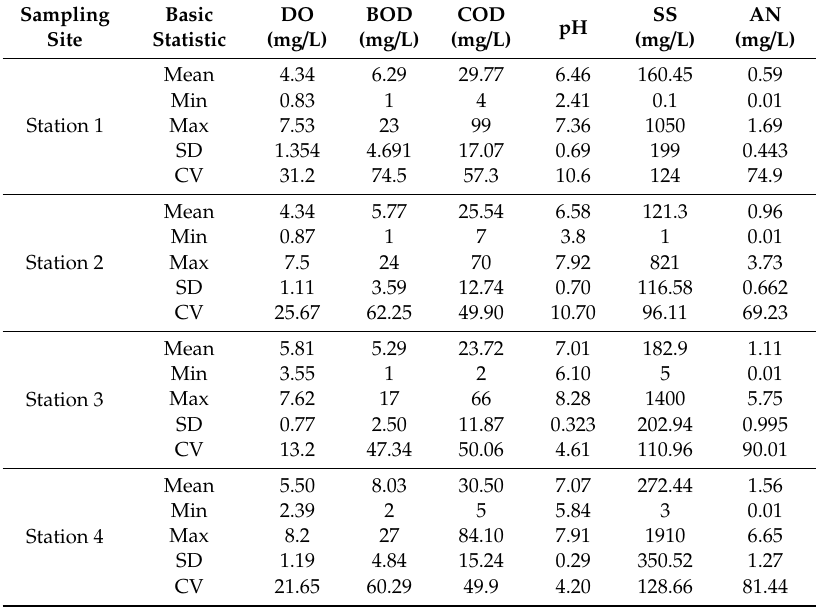
Table 1. Basic statistics of the measured water quality parameter in Langat River.